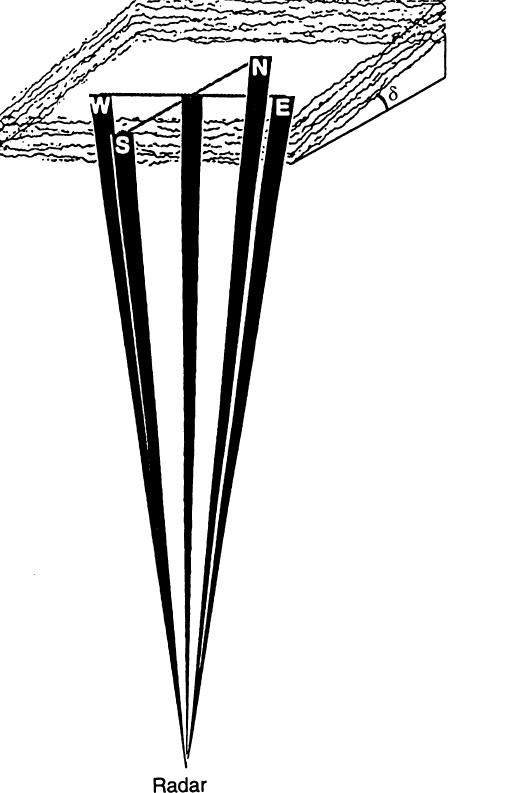
Fig. 2 . Schematic diagram showing a 5-beam radar arrangement, and scattering layers tilted in a N–S direction, but not E–W, which would give an echo power imbalance between N and S beams, but not between E and W